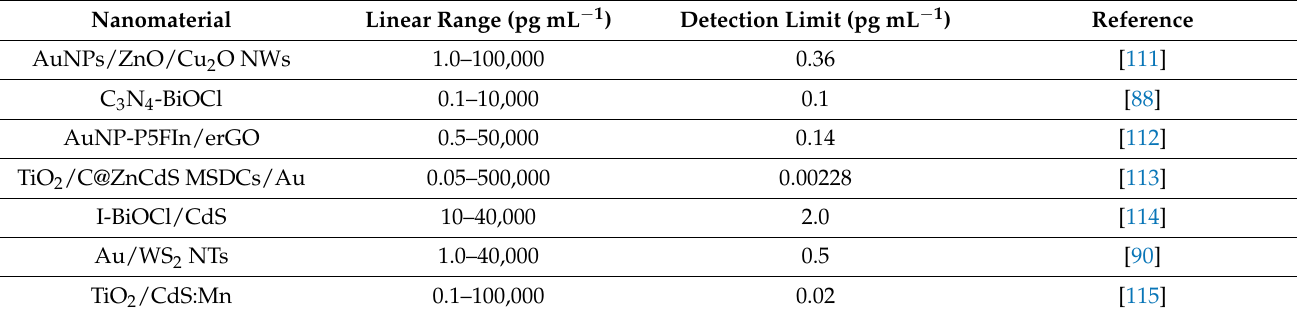
Table 3. Analytical performances of various photoelectrochemical immunosensors for the determination of